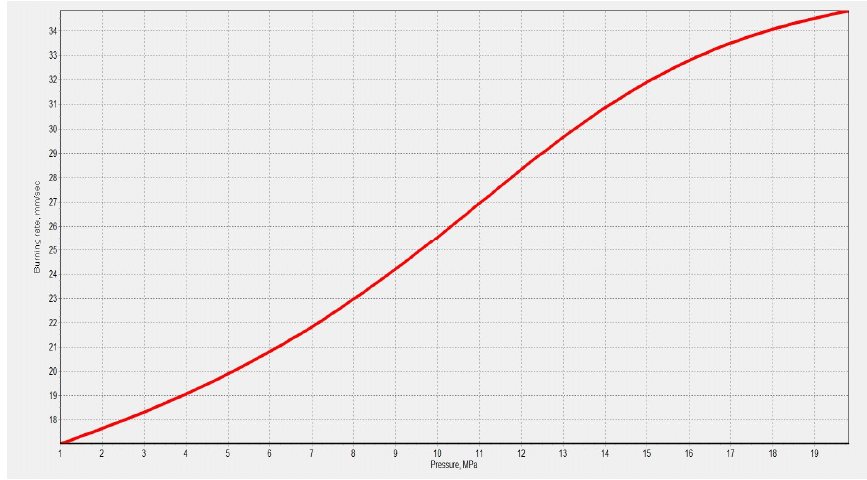
Figure 4. A representative dependence of burning rate on pressure for the case 1 in Table 1.